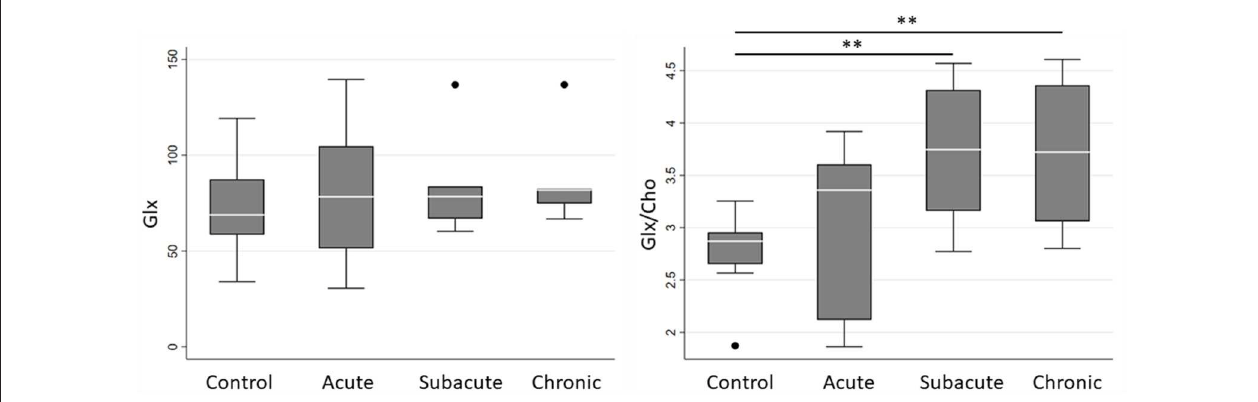
FIGURE 2 | Boxplot representations comparing median and interquartile range for total thalamus Glx and Glx/Cho between controls and concussed patients at acute, subacute and chronic time points. Individual horizontal bars are presented for each significant group comparison. Glx = glutamate + glutamine, Cho = choline compounds. ** P < 0.05 by Mann-Whitney